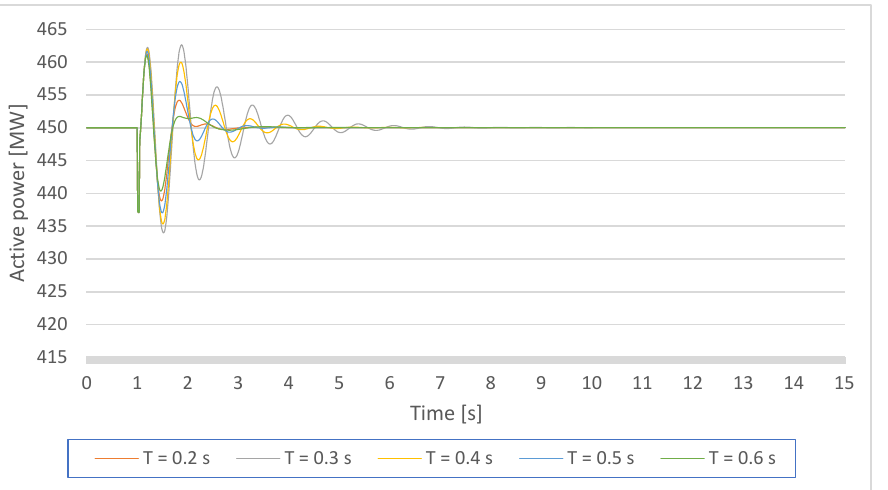
Figure 9. Gen1 active power response on a small disturbance with PSS parameters K = 10, and T = T i , 1 = 0.2–0.6 s.